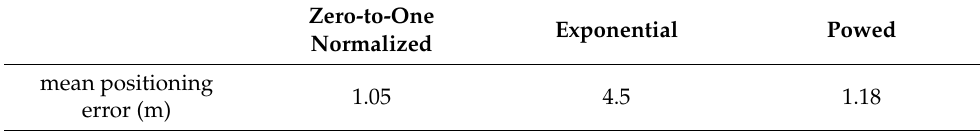
Table 5. Comparison of different Normalization method on the Alcala Tutorial 2017